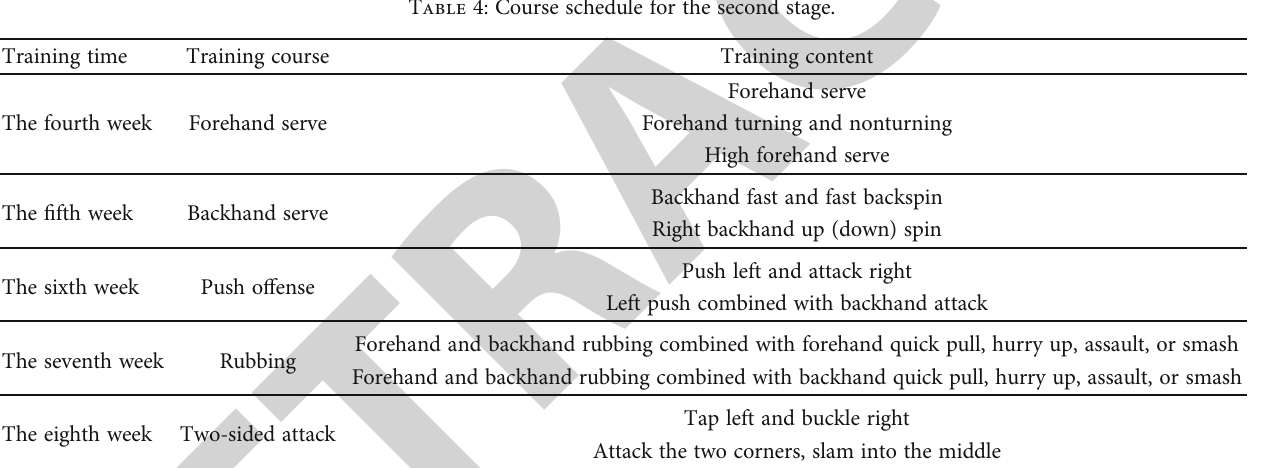
Figure 7: Comparison of basic indicators between the test group and the control group before and after the experiment. Table 4: Course schedule for the second